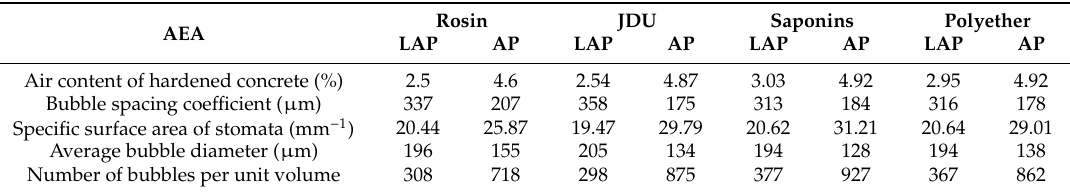
Table 6. Bubble characteristics of hardened concrete under di ff erent AP (equivalent dosage of air entraining agent).